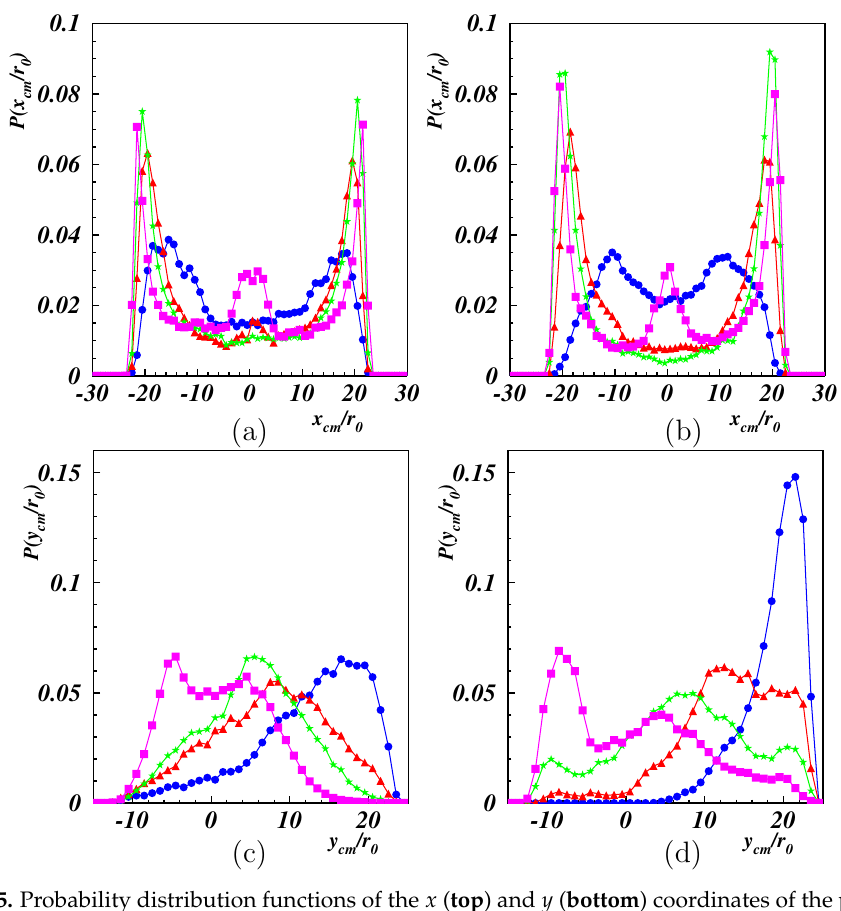
Figure 5. Probability distribution functions of the x ( top ) and y ( bottom ) coordinates of the polymer center of mass for L p / L = 0.5 ( left ), 2 ( right ) and Wi = 10 ( • ) ,25 ( (cid:78) ) ,50 ( (cid:63) ) ,100 ( (cid:4) ) .